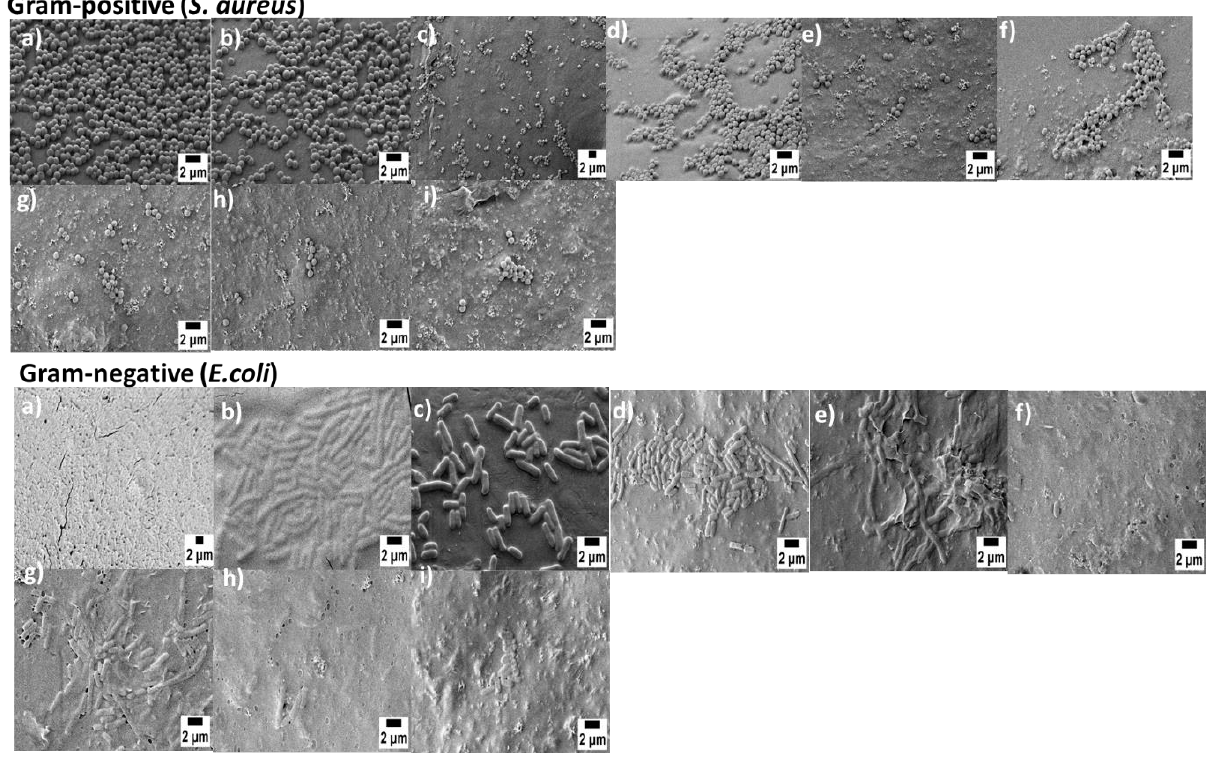
Figure 7. SEM images showing antibacterial effect on Gram-positive S. aureus ( top ): PCL ( a ), PCL/13-93 ( b ), PCL/13-93B3 ( c ), PCL Coat 1 ( d ), PCL/13-93 Coat 1 ( e ), PCL/13-93B3 Coat 1 ( f ), PCL Coat 2 ( g ), PCL/13-93 Coat 2 ( h ), PCL/13-93B3 Coat 2 ( i ), and on Gram-negative E. coli bacteria ( bottom ): PCL ( a ), PCL/13-93 ( b ), PCL/13-93B3 ( c ), PCL Coat 1 ( d ), PCL/13-93 Coat 1 ( e ), PCL/13-93B3 Coat 1 ( f ), PCL Coat 2 ( g ), PCL/13-93 Coat 2 ( h ), PCL/13-93B3 Coat 2 ( i ).